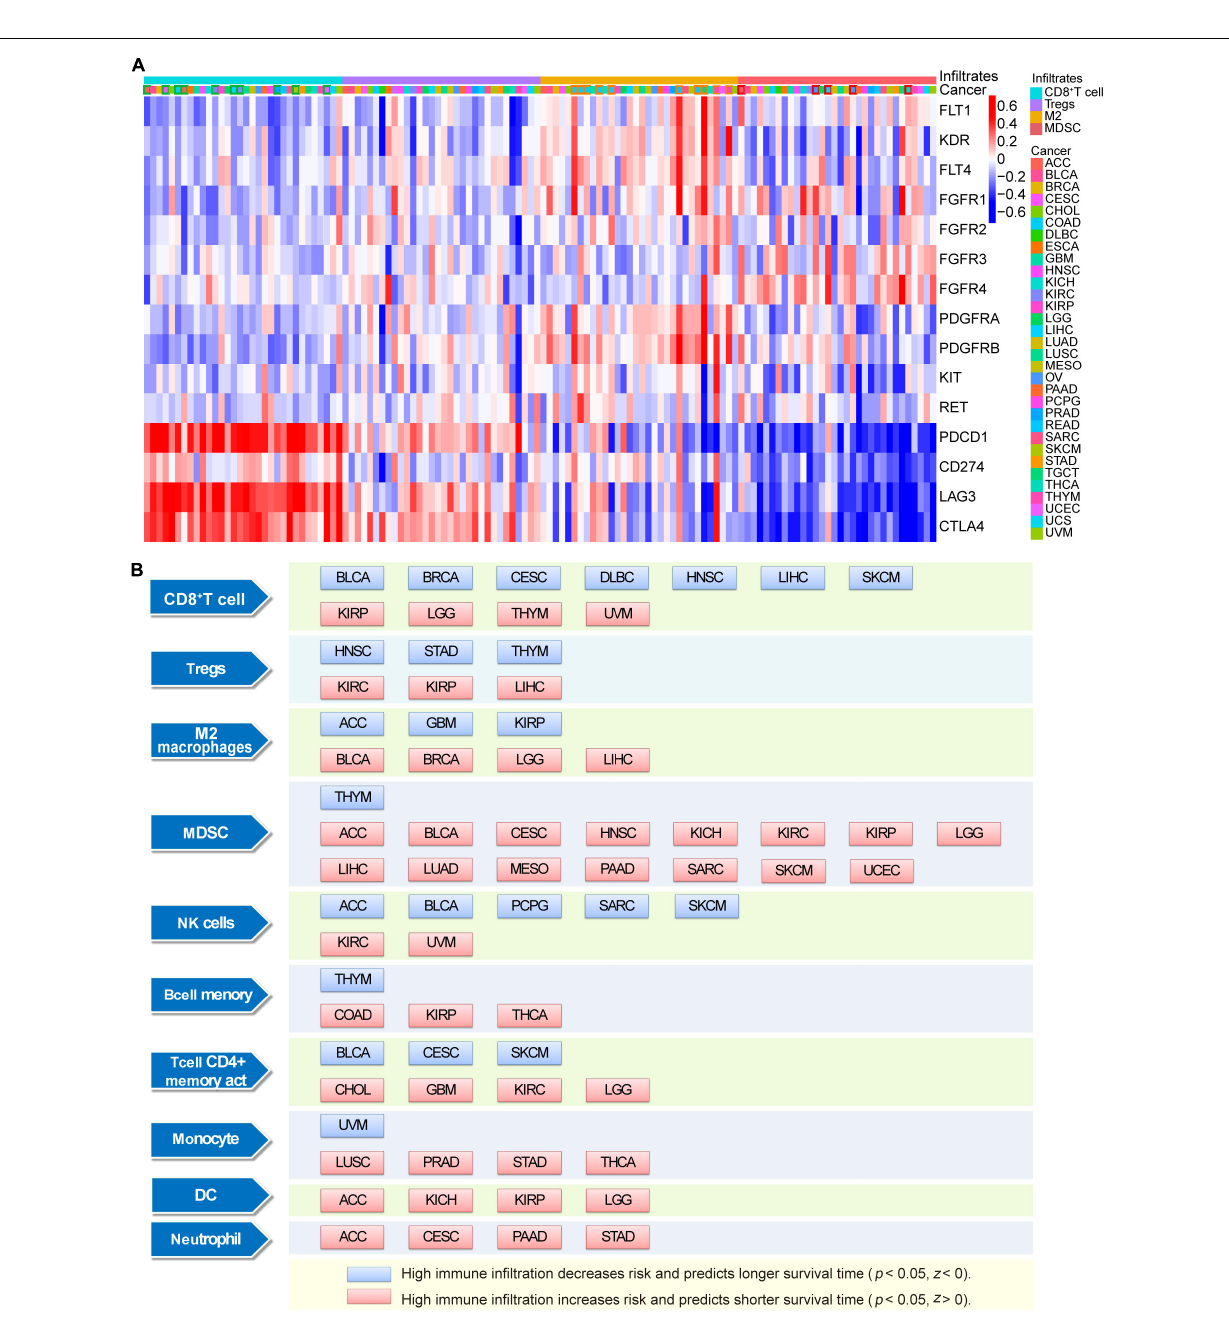
( Figure 1B ; Kudo et al., 2018; Zhu et al., 2018; Finn et al., 2020). In THCA, there was an overall strong negative